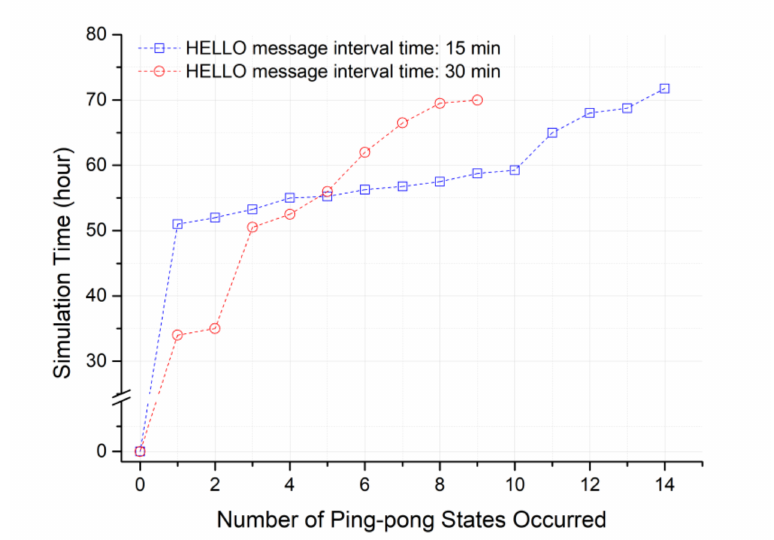
Figure 11. Occurrence time of ping-pong states in terms of the number of ping-pong states for the previous scheme (currently the proposed scheme has NO ping-pong in this